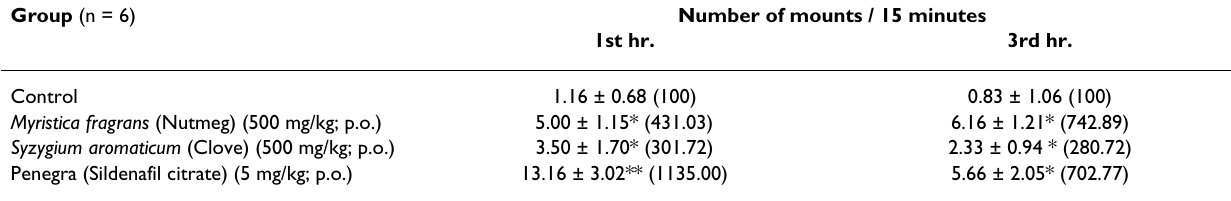
Table 1: Effect of Myristica fragrans (Nutmeg) and Syzygium aromaticum (Clove) on Mounting behaviour of Male Mice Group (n =